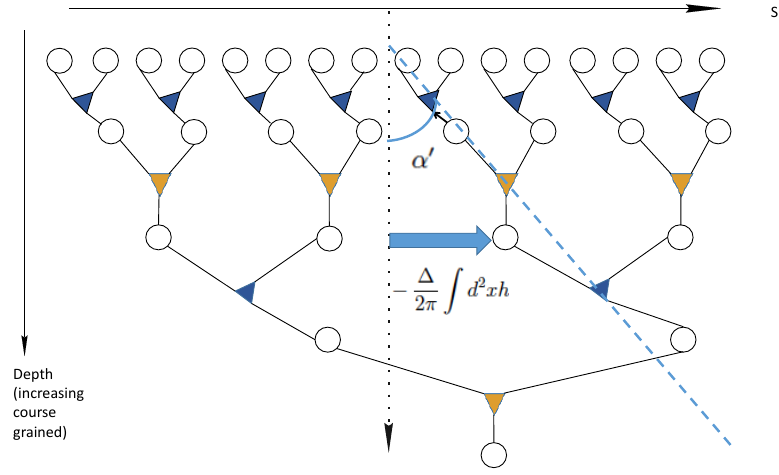
Figure 4 . The chiral structure of TN for warped CFT creates a deformed version of warped AdS space. The blue triangles could be a combination of chiraleons and disentanglers. Also, yellow triangles here are isometric coarse graining transformations and circles are the lattice sites. So this structure due to the presence of chiraleons does not have a dilation invariance in the left